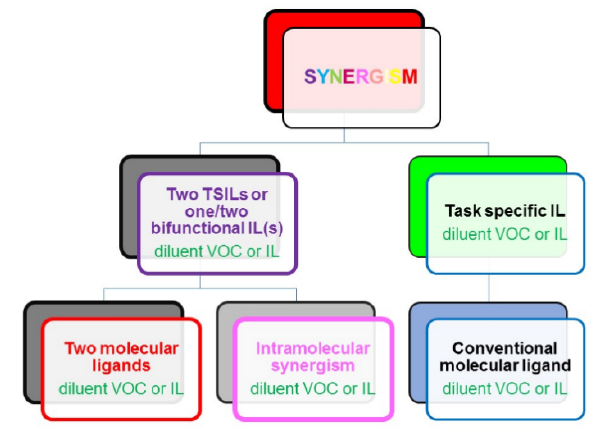
Figure 8. Evolution of the solvent extraction chemistry of 4f ions. Table 3. Recommended and provisional data (noted as “P”) for synergistic systems containing β -diketone and organophosphorus ligands used for the solvent extraction of trivalent lanthanoids.